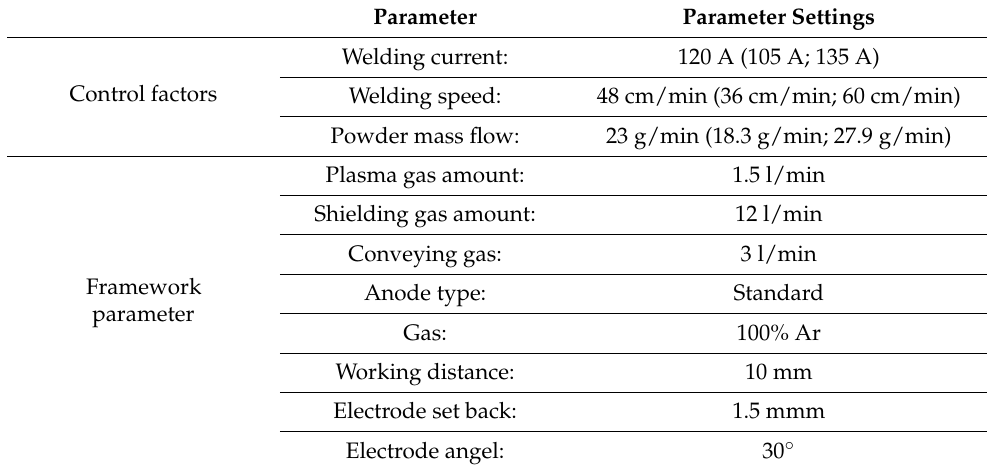
Table 1. Parameter setup for